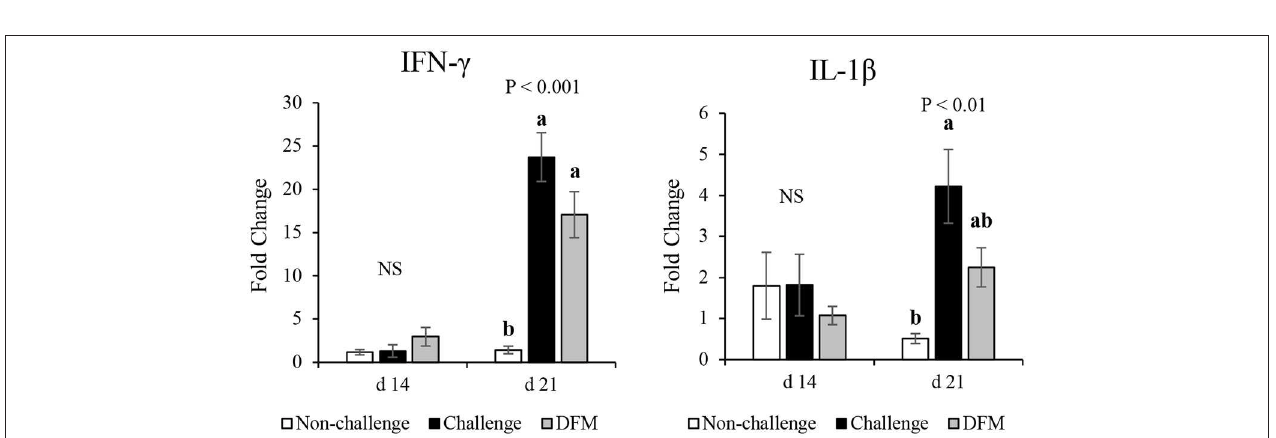
FIGURE 5 | Effect of dietary DFM supplementation on broiler gut tensile strength on d 22. Each bar represents the mean ± SE.